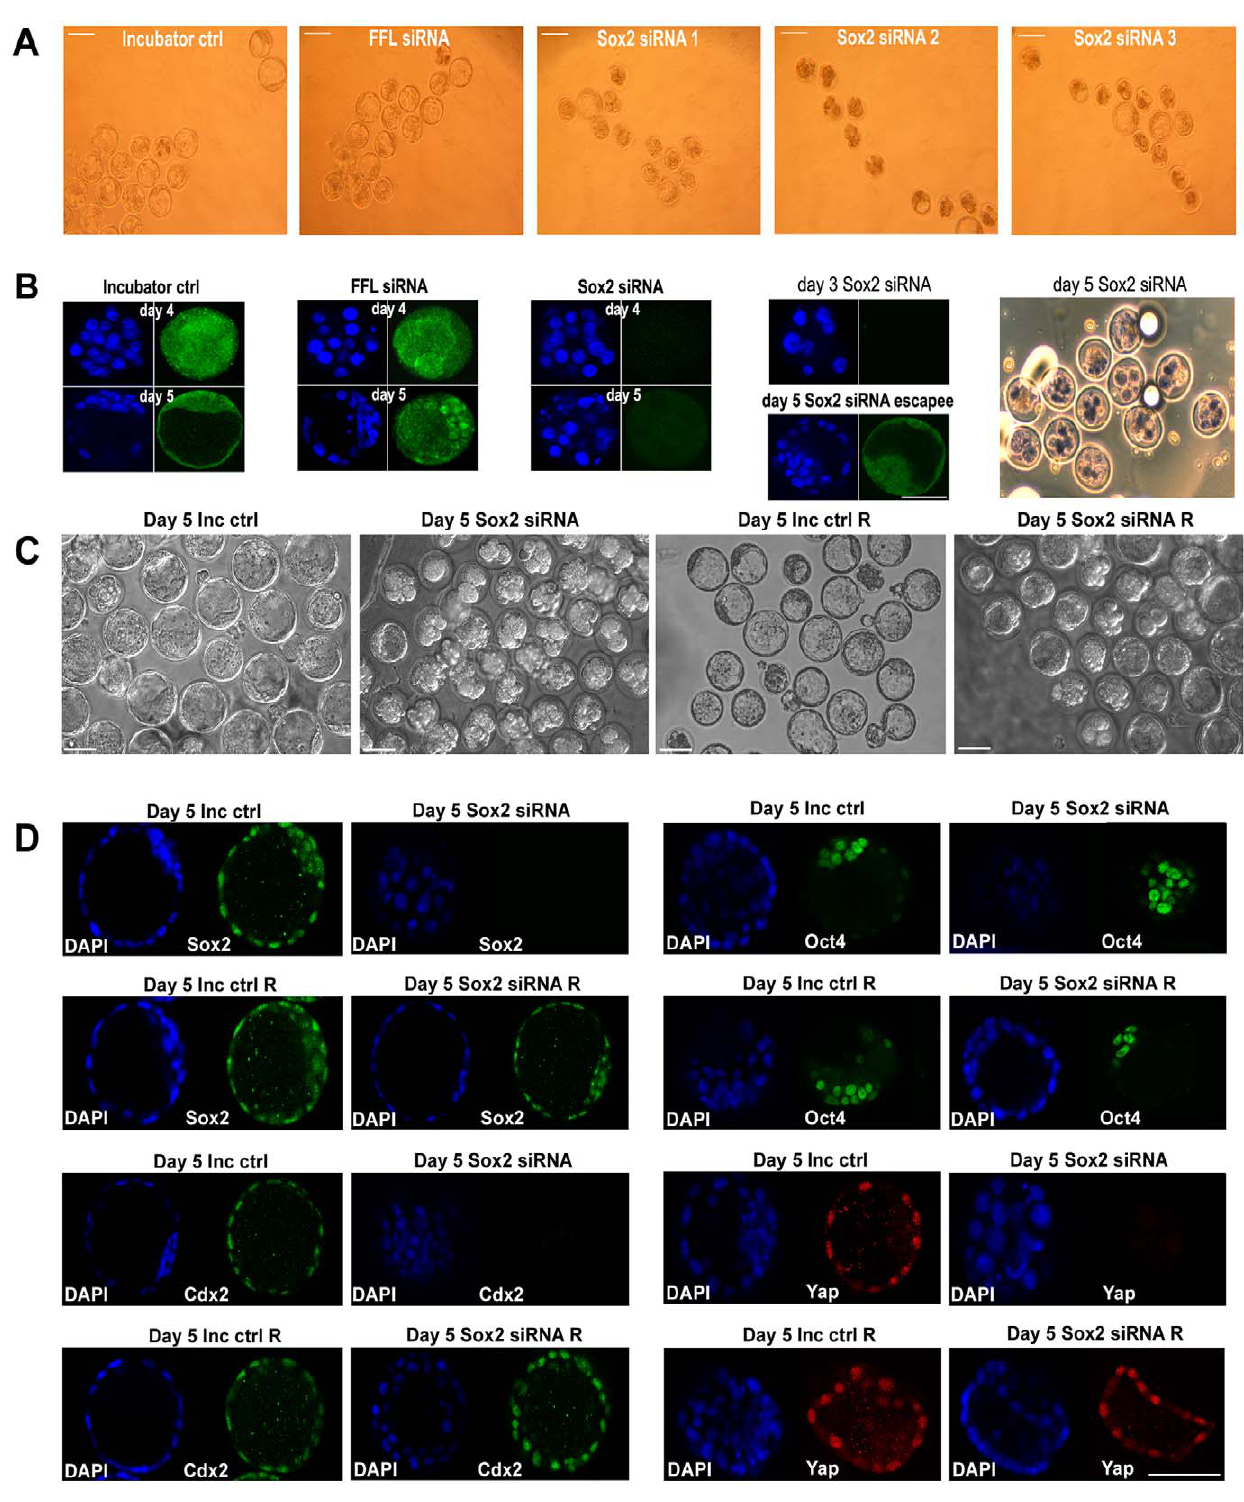
Figure 3. Sox2 expression in Sox2- siRNA and control MF1 x CD1 embryos. ( A ) Phase contrast images of day 5 incubator-control, FFL -siRNA, and Sox2 -duplex-1, - 2 and -3 siRNA embryos. While control embryos formed blastocysts, most Sox2 -siRNA embryos did not. Bars: 100 m m. ( B ) Control and Sox2 -duplex-2-siRNA embryos stained for Sox2 (Abcam) on days 4 and 5: single optical sections from confocal Z-series, DAPI-stained nuclei (blue) and Sox2 (green); bar: 50 m m. Decreased Sox2 protein expression was observed in Sox2 knock-down morulae on day 4, which persisted on day 5. Absence of Sox2 protein on day 3, as a result of the Sox2 -siRNA knock-down on day 2, was also confirmed. A few blastocysts forming on day 5 within the Sox2 - siRNA group (‘escapees’ from the siRNA effect) showed some Sox2-staining, although less than incubator-control blastocysts. The lethality of the Sox2 - siRNA phenotype on day 5 was assessed by Trypan Blue up-take. Presence of non-viable (blue) cells was apparent in 10 out of the 12 day 5 Sox2 -siRNA embryos examined. ( C ) Rescue phenotype in MF1 x CD1 embryos: Sox2 -siRNA and incubator-control embryos were cultured with and without cell-